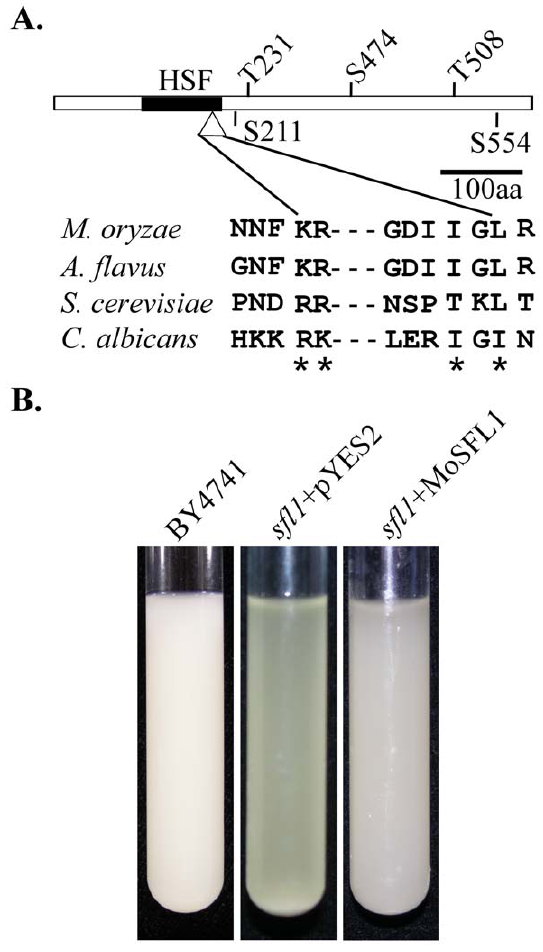
Figure 2. Structural elements of MoSfl1 and complementation assays with the yeast sfl1 mutant. A. The MoSfl1 protein contains a heat shock factor (HSF) domain (black box), a MAPK docking site (triangle), three putative MAP kinase phosphorylation sites (T231, S474, and T508), and two putative PKA phosphorylation sites (S211 and S554). The amino acid sequence of the MAPK docking site is conserved among Sfl1 and its orthologs from Magnaporthe oryzae , Aspergillus flavus , and Candida albicans . B. Expression of MoSFL1 suppressed the flocculation defect of the yeast sfl1 mutant. Cultures of Saccharomyces cerevisiae wild type strain BY4741 ( SFL1 ) and transformants of D sfl1 carrying pYES2 or pYES2- MoSFL1 were shaken at 30 u C for 16 h and kept still for 15 min before being photographed.